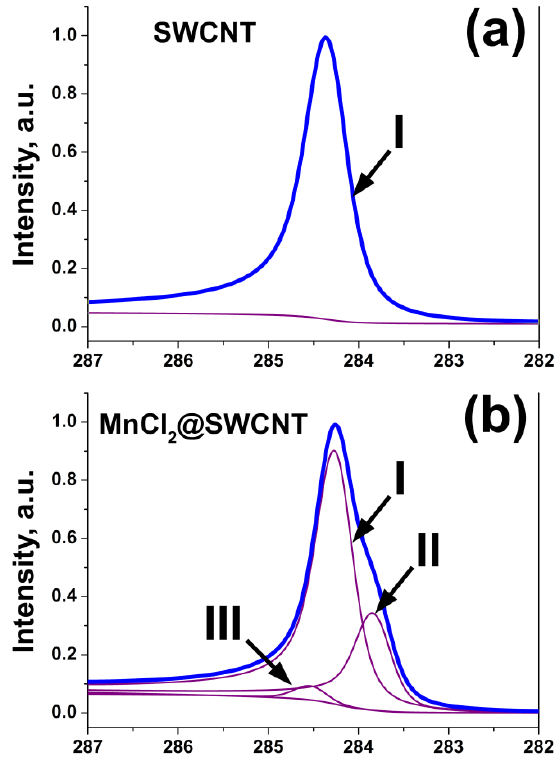
Figure 6. The C 1s XPS spectra of the pristine SWCNTs ( a ) and nanotubes filled with manganese chloride ( b ). The components I, II and III correspond to the unfilled, filled SWCNTs and local interactions, respectively. Reprinted by permission from [36]: SpringerNature, Applied Physics A, Kharlamova et al. Electronic properties of single-walled carbon nanotubes filled with manganese halogenides, copyright 2016. Table 3. Summary of doping-induced modifications of the C 1s XPS spectra of filled SWCNTs.